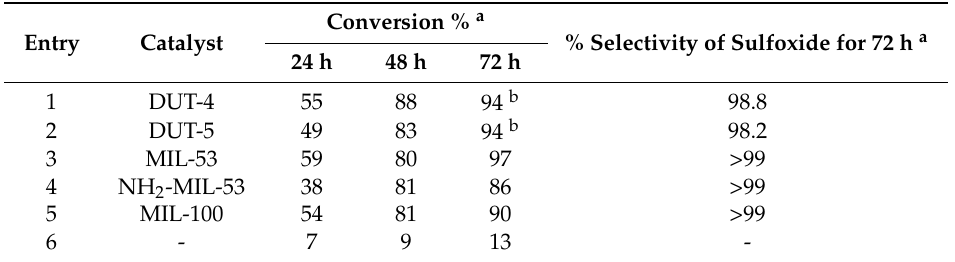
Table 3. Summary of selective oxidation of methyl phenyl sulfide to methyl phenyl sulfoxide catalyzed by Al-MOFs at room temperature.